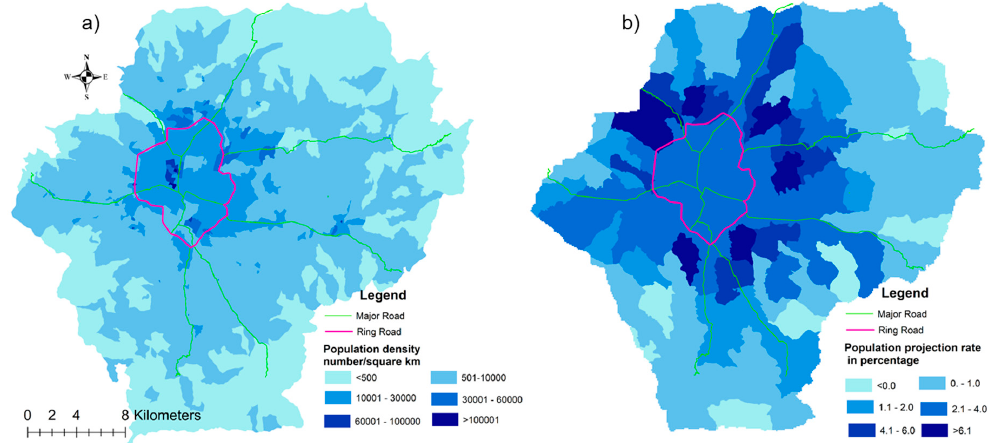
Figure 3. Estimating current and future population: ( a ) ward-wise population density for base year 2011, ( b ) adopted ward/VDC wise percentage annual growth rate.